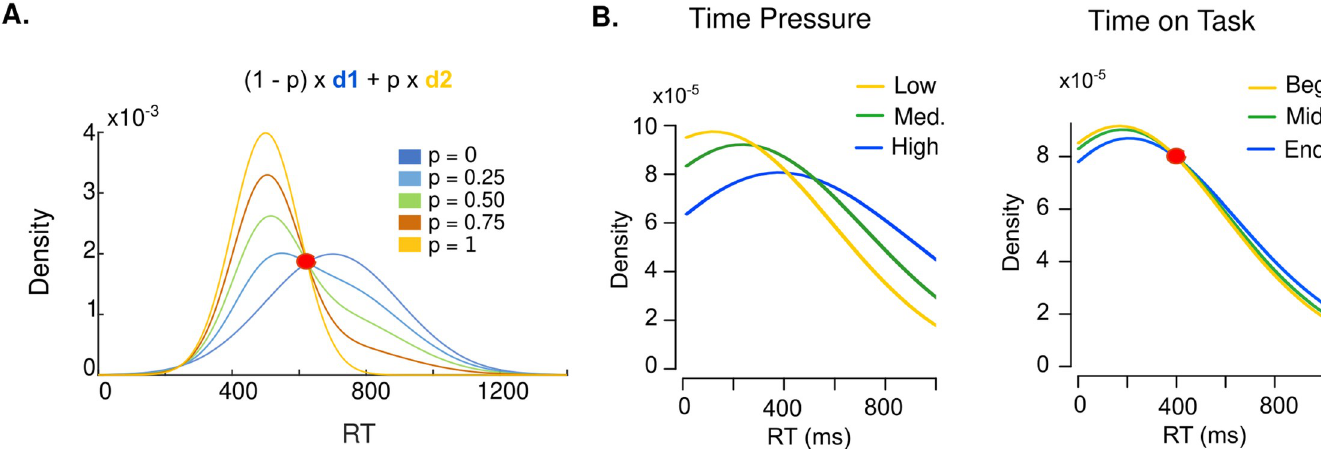
Fig 6. Fixed-point property of binary mixtures holds for time on task but not for time pressure. A. Theory. The fixed-point property entails that any mixture of two and d ) cross at the same common density point, regardless of the mixture proportion ( p ). Densities with various mixture proportions of d base distributions (here, d 1 2 and d 2 are displayed The red dot indicates the fixed-point. B. Smoothed histograms of response time distributions elicited by the different levels of time pressure (left) and time on task (right). Fixed-point analysis (see main text and Methods) suggest that the response time distribution elicited by the different levels of time pressure do not cross the same common density point (left), whereas the response time distributions elicited by the different levels of time on task do (right).